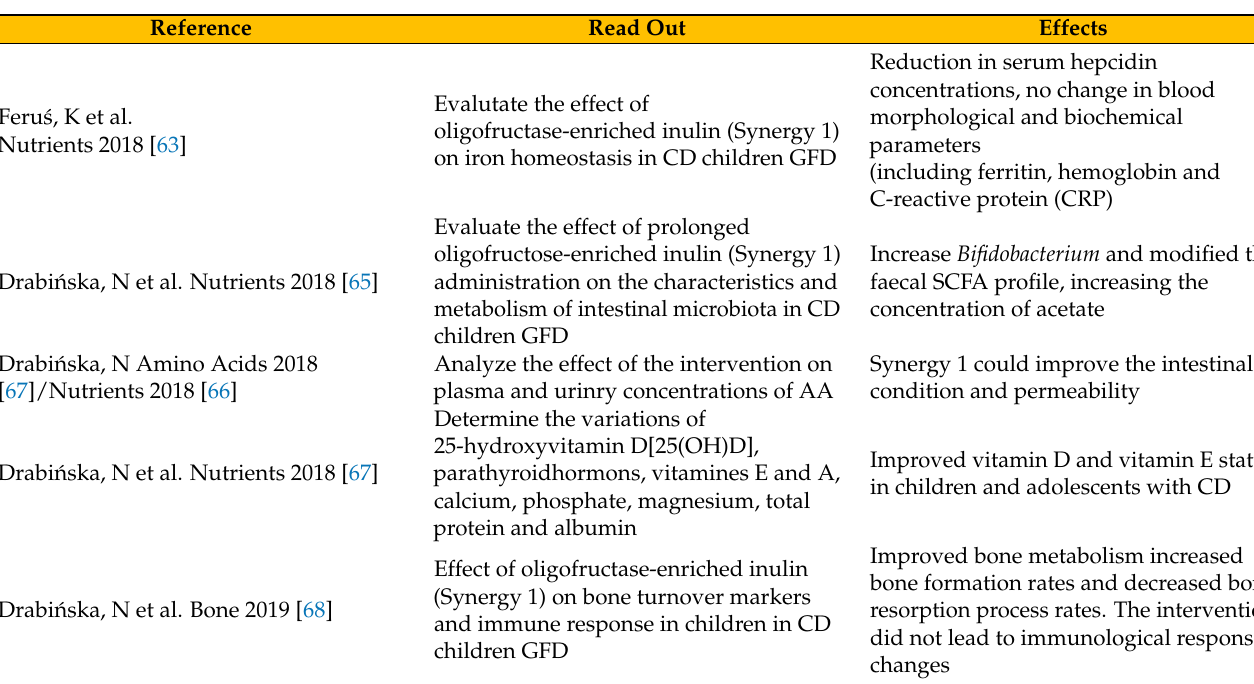
Table 6. Effect of prebiotics in vivo